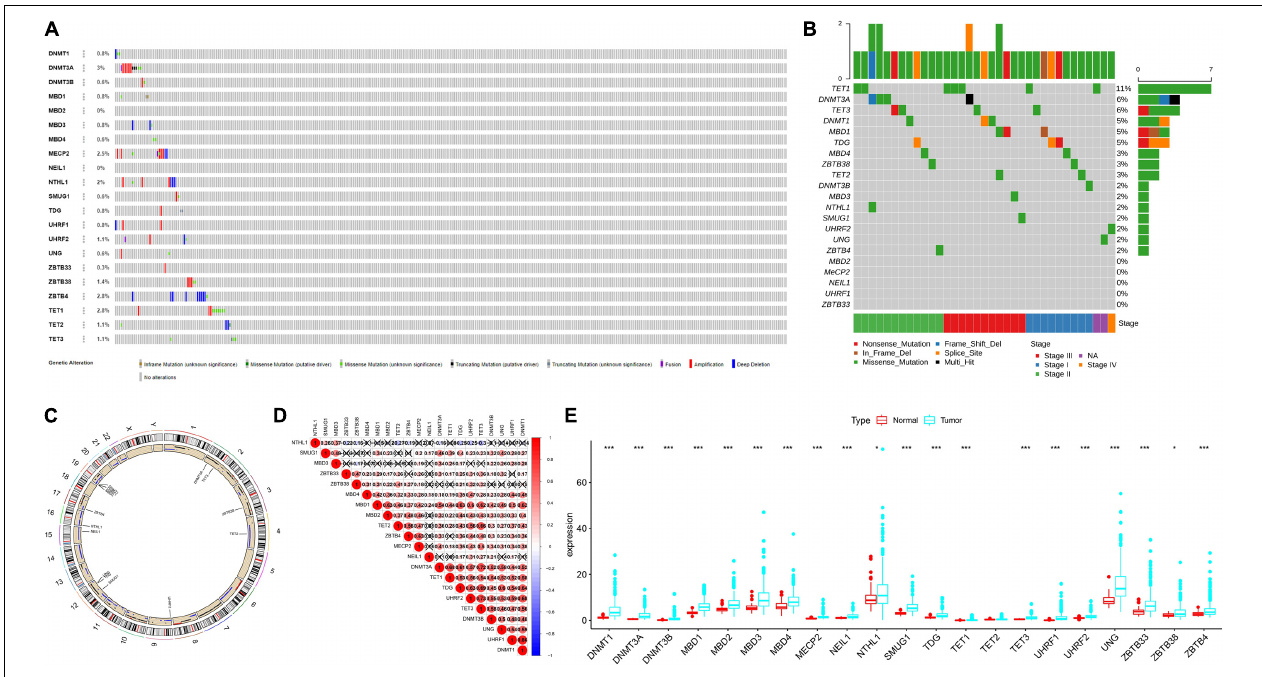
FIGURE 2 | The landscape of genetic variation of 5mC regulators in HCC Panel. (A) Data on the somatic mutation and copy number variations of 21 5mC regulators. (B) Waterfall plot of somatic mutation. (C) Location of CNV alteration of 5mC regulators on chromosomes. (D) Correlation between 21 5mC regulators in HCC. (E) The results of differentially expressed analysis from 5mC regulators. In panel (E) , * p < 0.05, ** p < 0.01, *** p < 0.001.